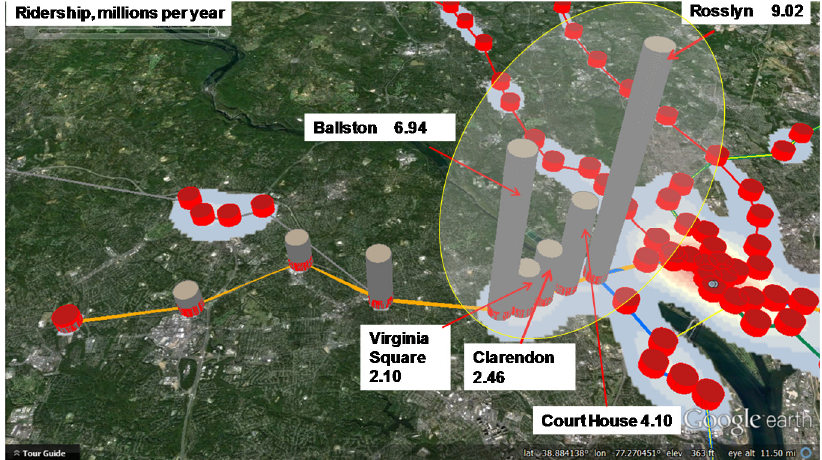
Figure 9. Metro ridership in the Rosslyn-Ballston Corridor. Red dots represent locations of transit stations, and grey bars represent ridership. When comparing Figures 8 and 9, note that highest ridership coincides with tall buildings clusters.